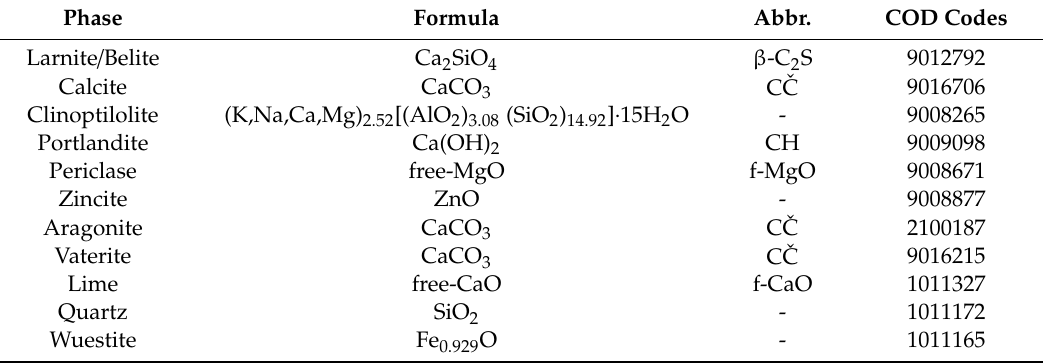
Table 4. Phases and crystallography open database (COD) codes used for Rietveld